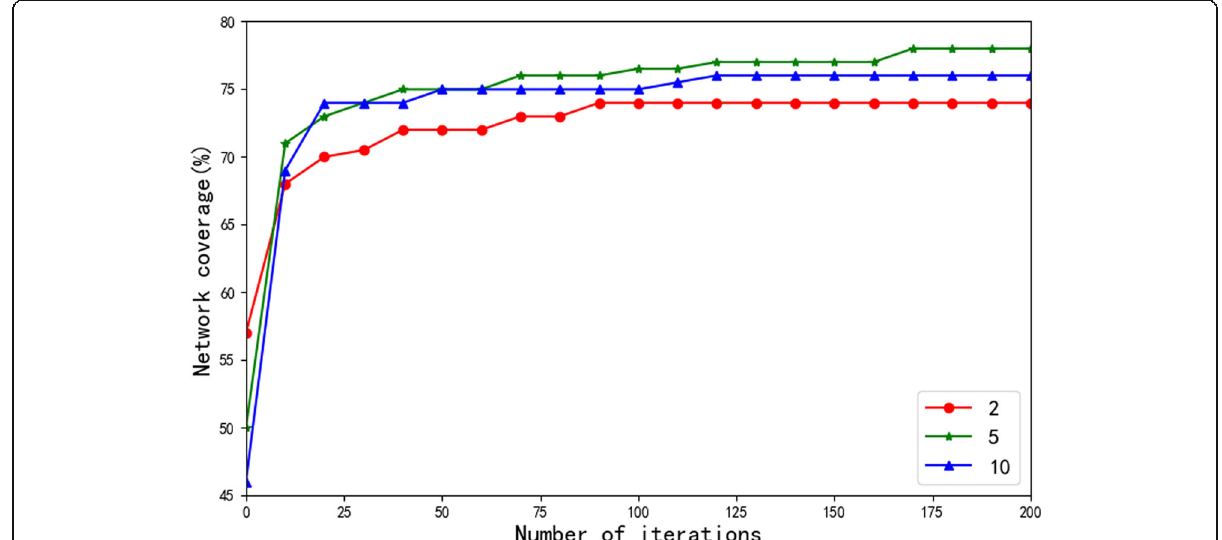
Fig. 3 Comparison of different search length coverage ratios. The population size SizePop is set to 50, the number of iterations Maxgen is set to 200, and the search length L is set to 2 m, 5 m, and 10 m, respectively. The result is shown in this figure